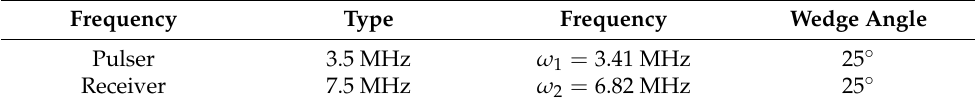
Table 4. Experimental conditions for phase matching mode technique.